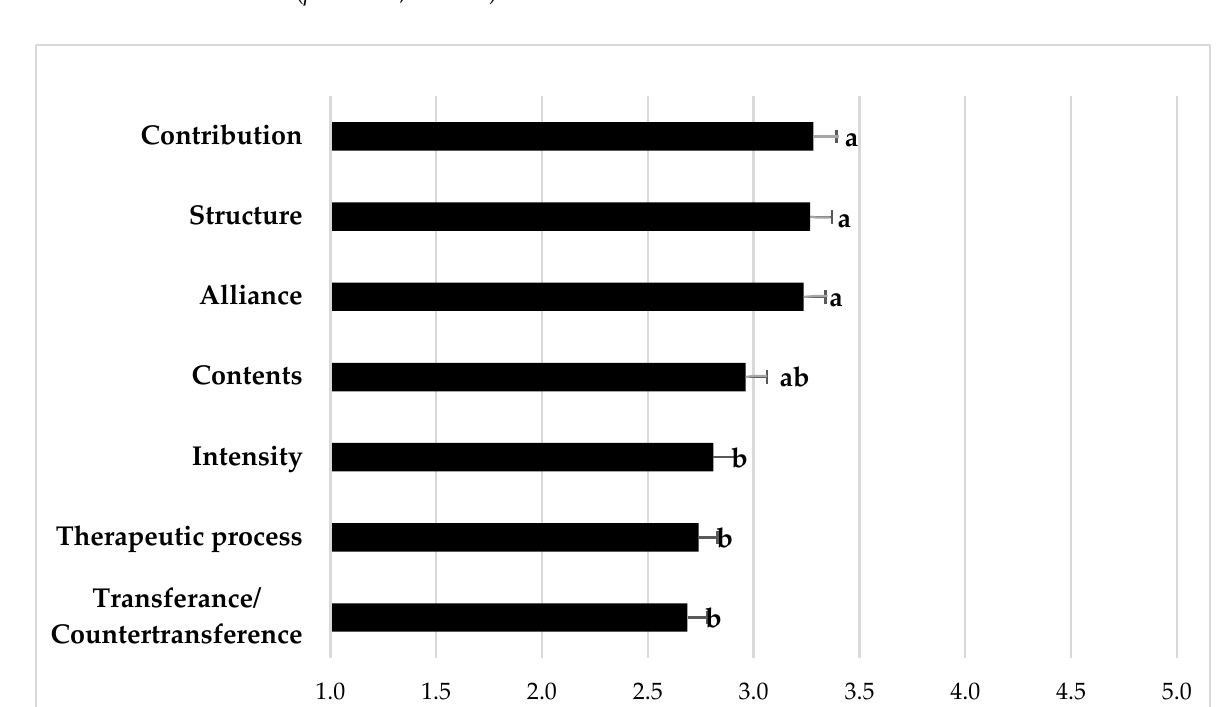
Figure 1. Therapists’ rating of experienced changes through the remote setting (videoconferencing, telephone) concerning the different aspects. Note: Psychotherapists rated their experienced change on a 5-point scale from 1 “very strong change” to 5 “no change”. Data are shown as least square means (LSM) ± standard error of the means. a,b Different superscripts indicate differences among LSM of the topics at p < 0.05 after Bonferroni-correction. Table 8. Willingness to move to remote psychotherapy by